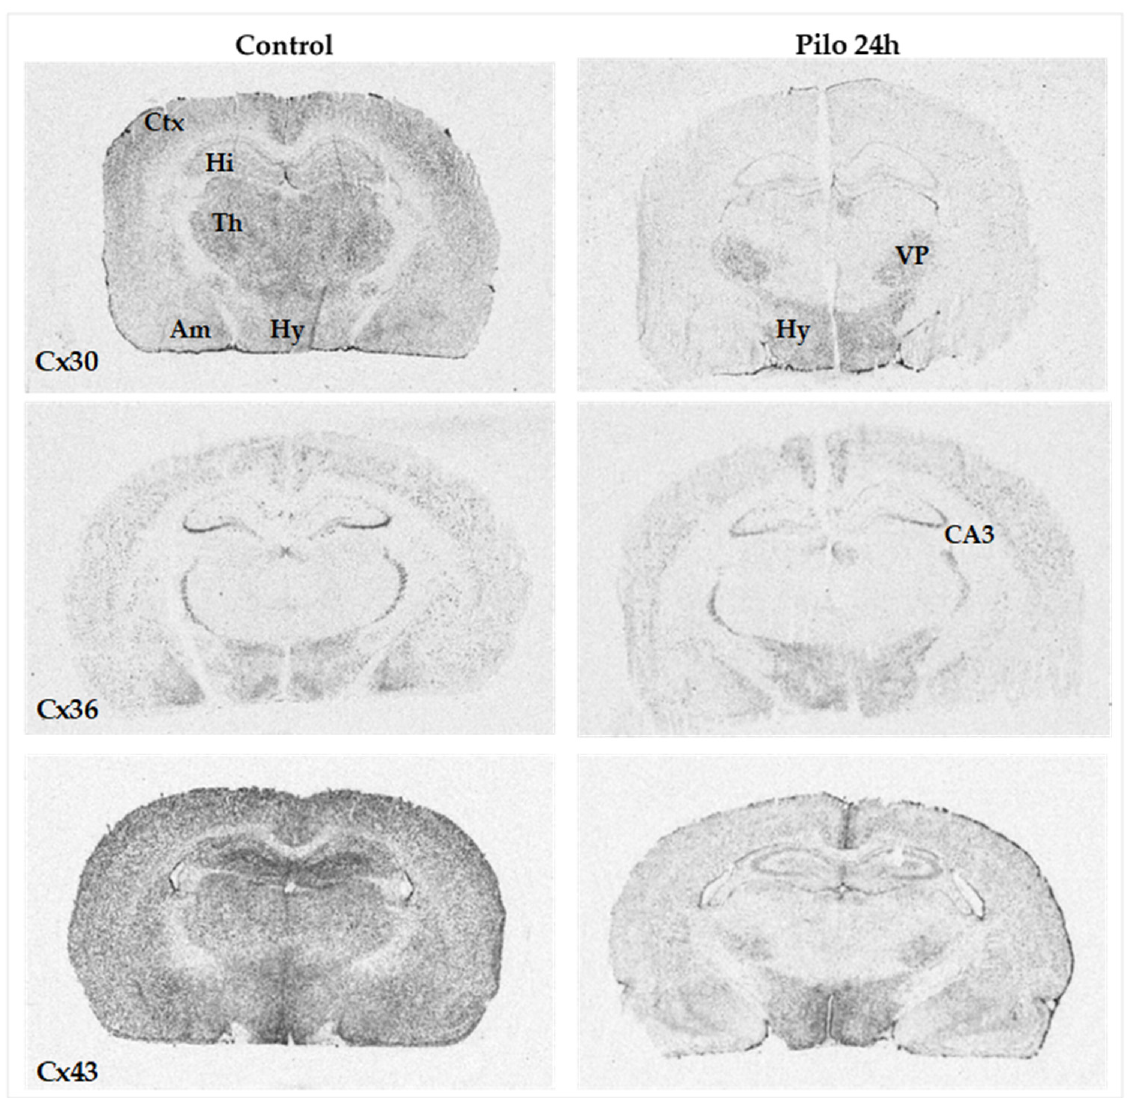
Figure 1. In situ hybridization analysis of Cx30 , Cx36, and Cx43 mRNAs in adult rat brains 24 h after the onset of pilocarpine-induced seizures lasting 3 h. Representative autoradiograms obtained from brain coronal sections using specific antisense probes for each connexin mRNA. Note the dramatic decrease in Cx30 and Cx43 mRNA levels at 24 h. Am, amygdaloid nuclei; Ctx, cerebral cortex; Hi, hippocampus; Hy, hypothalamus; Th, thalamus; VP, ventroposterior thalamic complex; CA3, CA3 subfield of the hippocampal region.